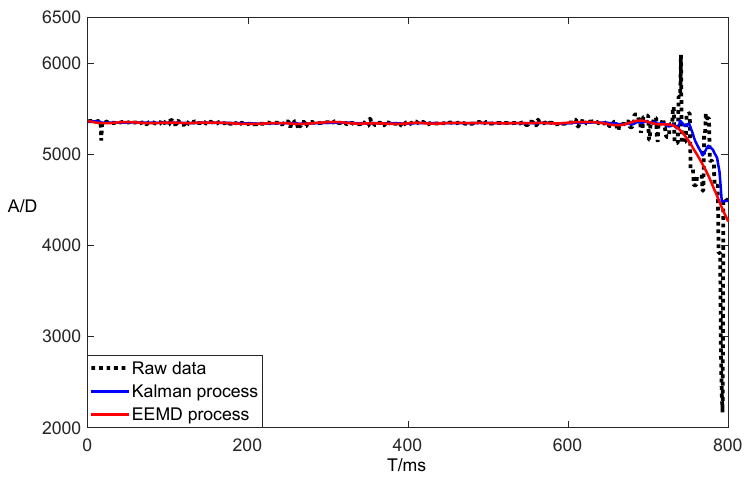
Figure 16. Filter e ff ect contrast diagram. Figure 16. Filter effect contrast